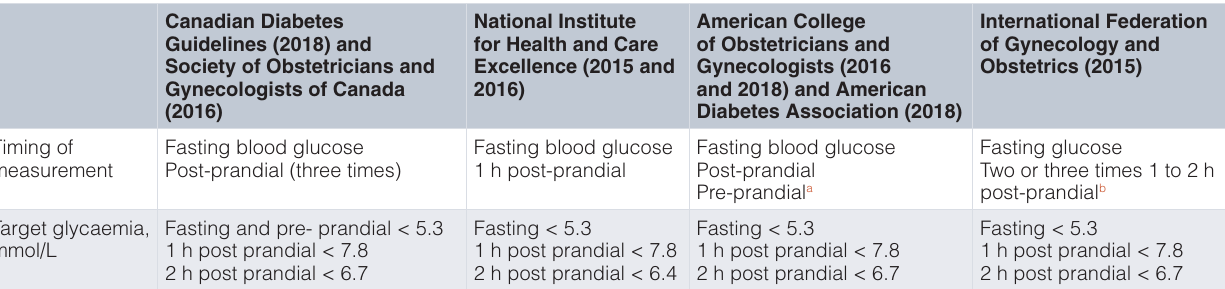
Table 1. Societal guidelines regarding glucose monitoring and target glycaemia in